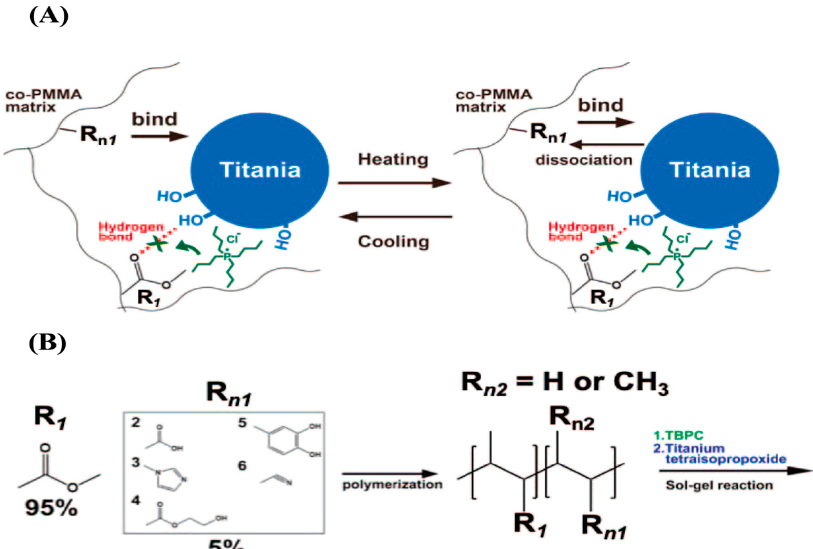
Figure 5. ( A ) TBPC inhibits hydrogen bonding between the carbonyl group of MMA (R1) and the hydroxy groups on the surface of titania particles. ( B ) Monomers with functional groups capable of bonding to the surface of titania particles; the functional group (Rn) of the other candidate monomer is thermally reversibly bound and unbound in the PMMA copolymer/titania hybrid material. Monomers with functional groups capable of radical polymerization: R2 is MA, R3 is VI, R4 is HE, R5 is DMA, and R6 is AN. From ref. [82]. Reprinted with permission from Ref. [82]. Copyright 2020 American Chemical Society.